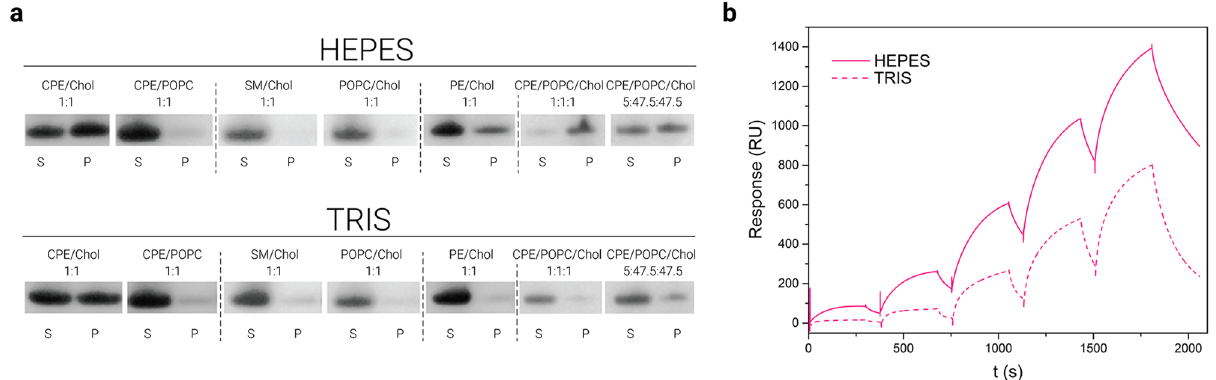
Figure 3. Binding analysis of RahU protein to CPE-enriched lipid vesicles. ( a ) Binding of RahU protein to multilamellar vesicles with various lipid compositions, as indicated with mole-to-mole ratios. The liposome- RahU co-sedimentation experiments were performed in either Hepes or Tris buffer as marked above the gels. The supernatant (S) and pellet (P) fractions were resolved on SDS-PAGE gels and stained with Coomassie Blue. For ease of comparison, results obtained in Hepes buffer and presented in Fig. 1a are shown also here. The dotted vertical dividing lines indicate the cropped parts of the same gel image. The full-length gels are shown in Fig. S1. ( b ) Binding of 4 µM RahU, either in 10 mM Hepes (solid line) or in 20 mM Tris buffer (dotted line) to the large unilamellar vesicles composed of equimolar CPE/POPC/cholesterol. Vesicles were immobilized to Biacore L1 chip to 9500–9600 RU and analytes were injected for 300 s at 10 μL/min flow rate. To show only the RahU-vesicle interaction, the baseline was set as 0 RU after vesicle immobilization. For ease of comparison, results obtained in Hepes buffer and presented in Fig. 1b are shown also here. Representative sensorgrams from two independent experiments are shown. S supernatant, P pellet, CPE ceramide phosphorylethanolamine, Chol cholesterol, POPC 1-palmitoyl-2-oleoyl- sn -glycero-3-phosphocholine, SM sphingomyelin, PE